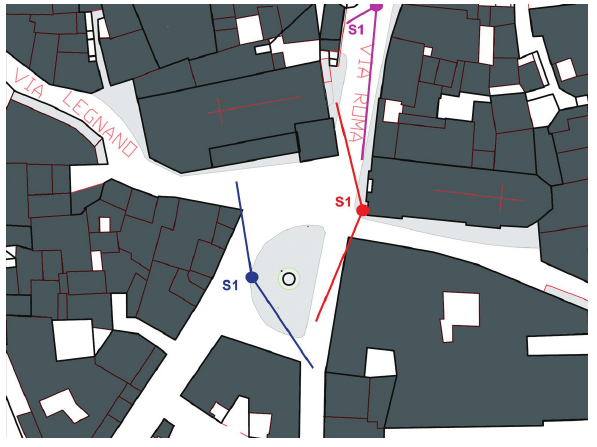
Figure 2. Data acquisition project